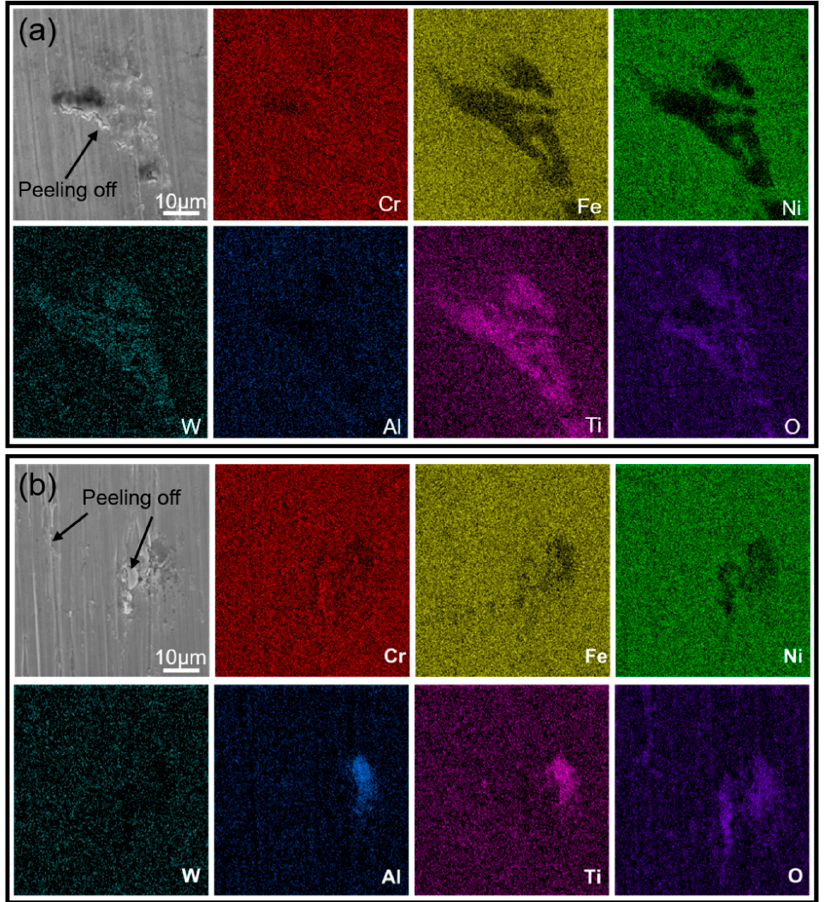
Figure 9. SEM images and mapping after oxidation at high temperature for 48 h. ( a ) As-cast, ( b ) SLM.